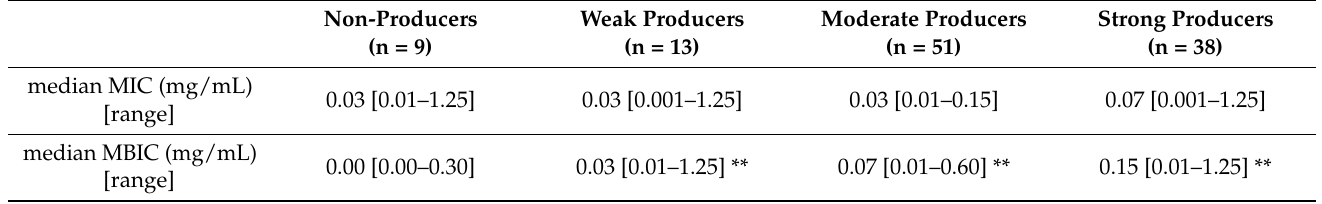
Table 2. Distribution of median minimum inhibitory concentration (MIC) and minimum biofilm inhibitory concentration (MBIC) values among non-producers, weak, moderate, and strong biofilm- producing